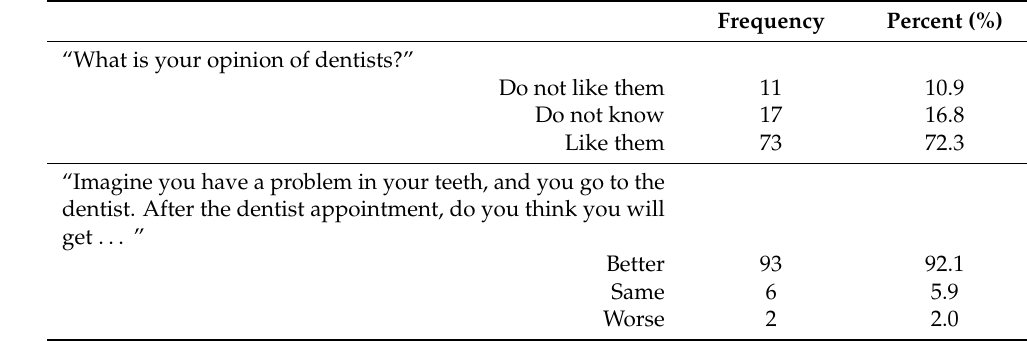
Table 2. Frequencies and percentages of children’s responses about their attitudes and opinions about